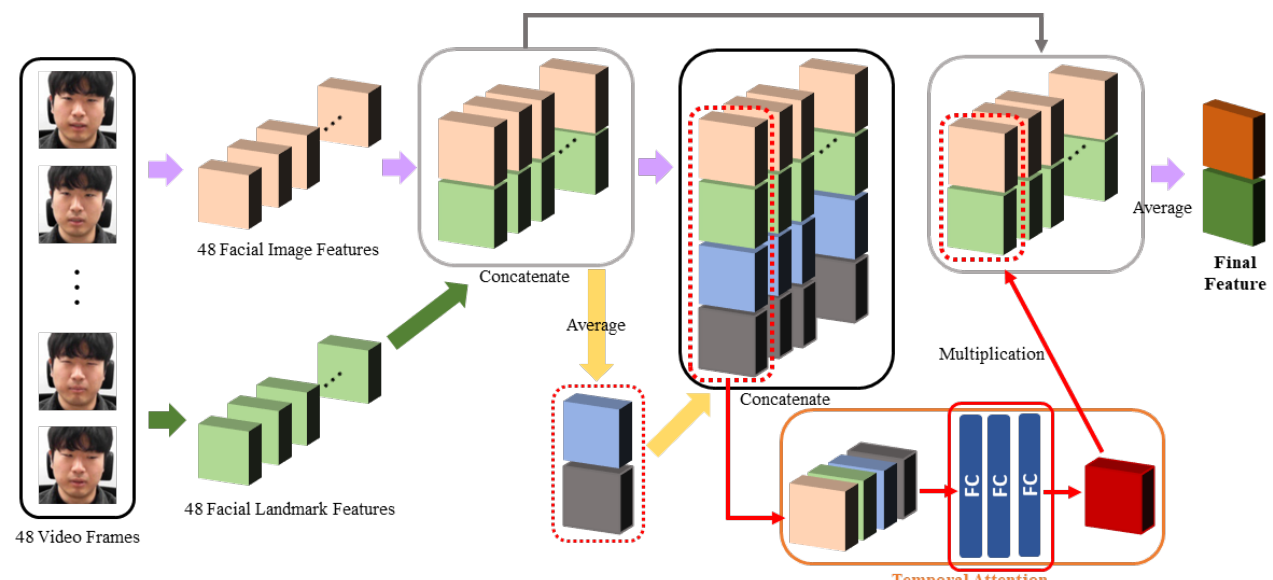
Figure 5. Structure of the temporal attention module. The attention weight increases when the frame is highly related to stress, considering the average feature representing 48 frames and the feature of a specific frame. FC: fully connected